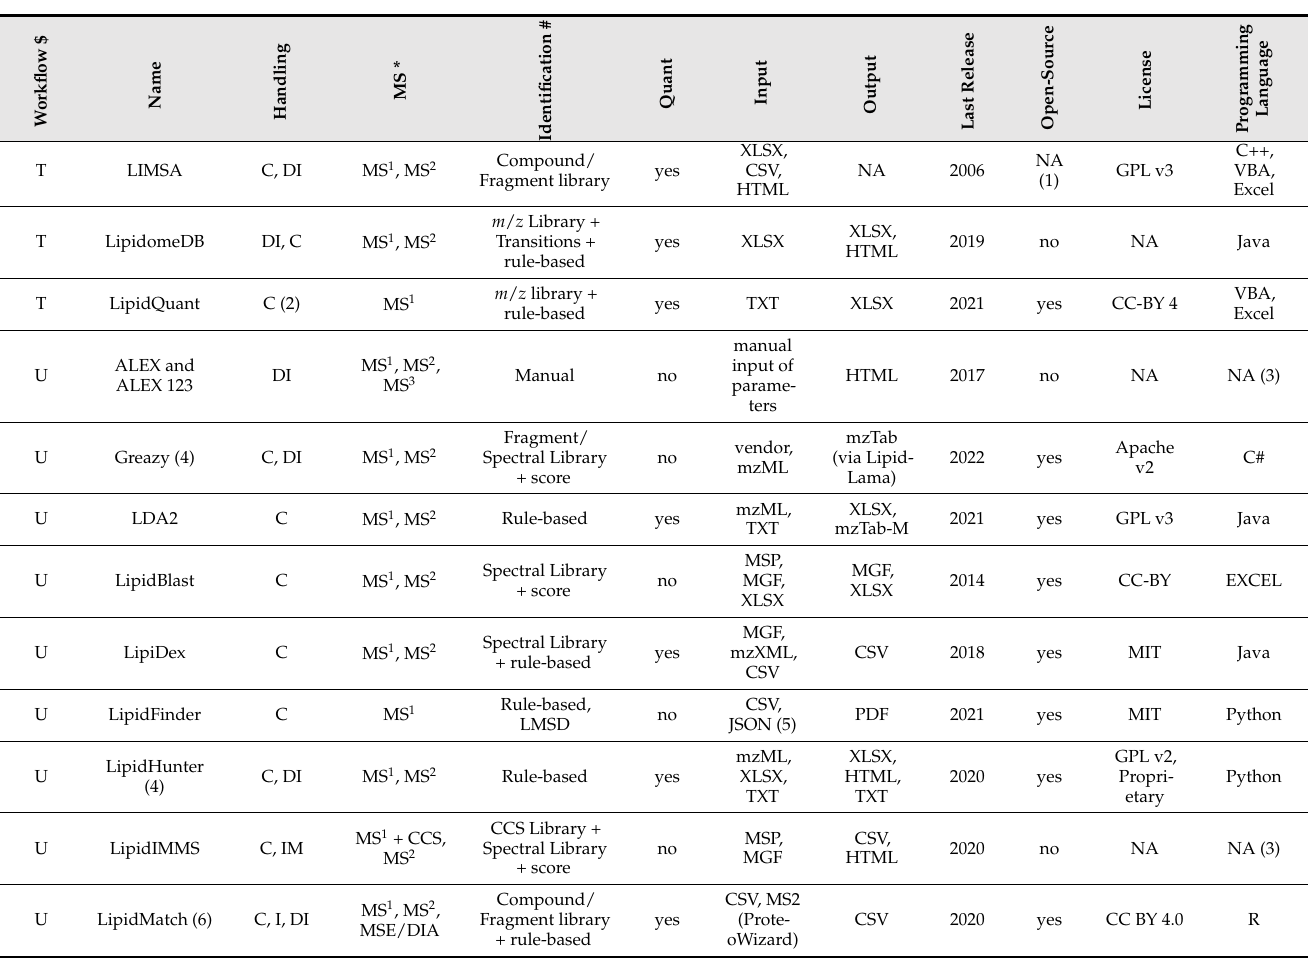
Table 1. Overview of software for lipid identification from mass spectrometry. Abbreviations: U: Untargeted, T: Targeted, C: Chromatography, CE: Capillary Electrophoresis, IM: Ion Mobility, DI: Direct Infusion (Shotgun), I: Imaging. $: targeted includes Selected Reaction and Multiple Reaction Monitoring (MRM), untargeted includes DDA and DIA approaches. *: Only the most important ones relevant to this review. All tools use some form of configuration file format, e.g., text-based (TXT) or other formats for libraries or fragmentation rules. Workflow assignment designates the primary workflow a tool was designed for and this was stated by the authors; others may be available. We use direct infusion as a more generic synonym for what is usually referred to as ‘shotgun lipidomics’. Comma-separated values (CSV) is a tabular, spreadsheet-like format. If tab characters are used as separators, the format is TSV. Hypertext markup language (HTML) is a format viewable with an internet browser. XLSX: MS office XML-based spreadsheet format. MSP: NIST mass spectral library format. MGF: Mascot Generic Format. BLIB: Binary mass spectral library format. PDF: Portable Document Format. #: rule-based validation often includes spectral scores, ratios and thresholds, scores denote spectral similarity functions, such as the commonly used dot product/cosine